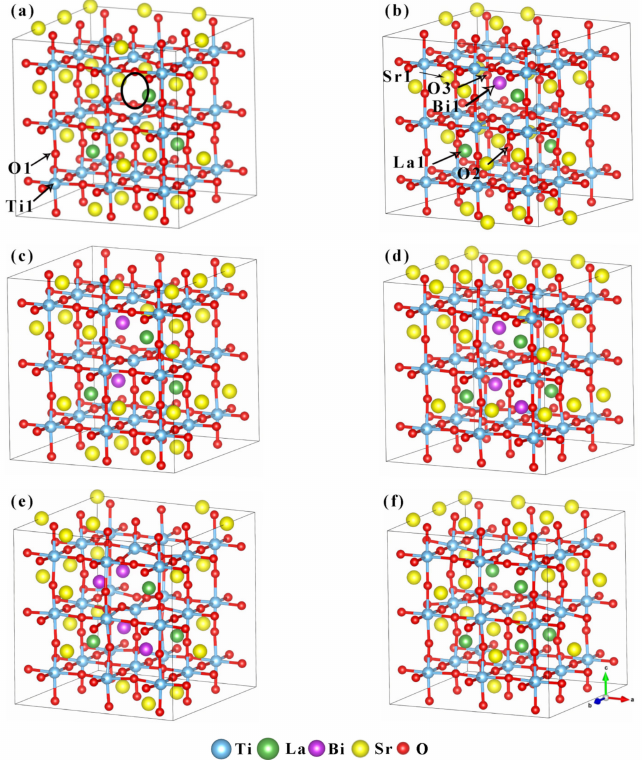
Figure 1. Cell models of (Sr 0.889-x La 0.111 Bi x )TiO 2.963. ( a ) Sr 0.889 La 0.111 TiO 2.963; ( b ) Sr 0.852 La 0.111 Bi 0.037 TiO 2.963; ( c ) Sr 0.815 La 0.111 Bi 0.074 TiO 2.963; ( d ) Sr 0.778 La 0.111 Bi 0.111 TiO 2.963; ( e ) Sr 0.741 La 0.111 Bi 0.148 TiO 2.963; ( f ) Sr 0.815 La 0.185 TiO 2.963 (the position of the black circle is the position where the O 2- vacancy is introduced, and the position of the O 2- vacancy is the same for each